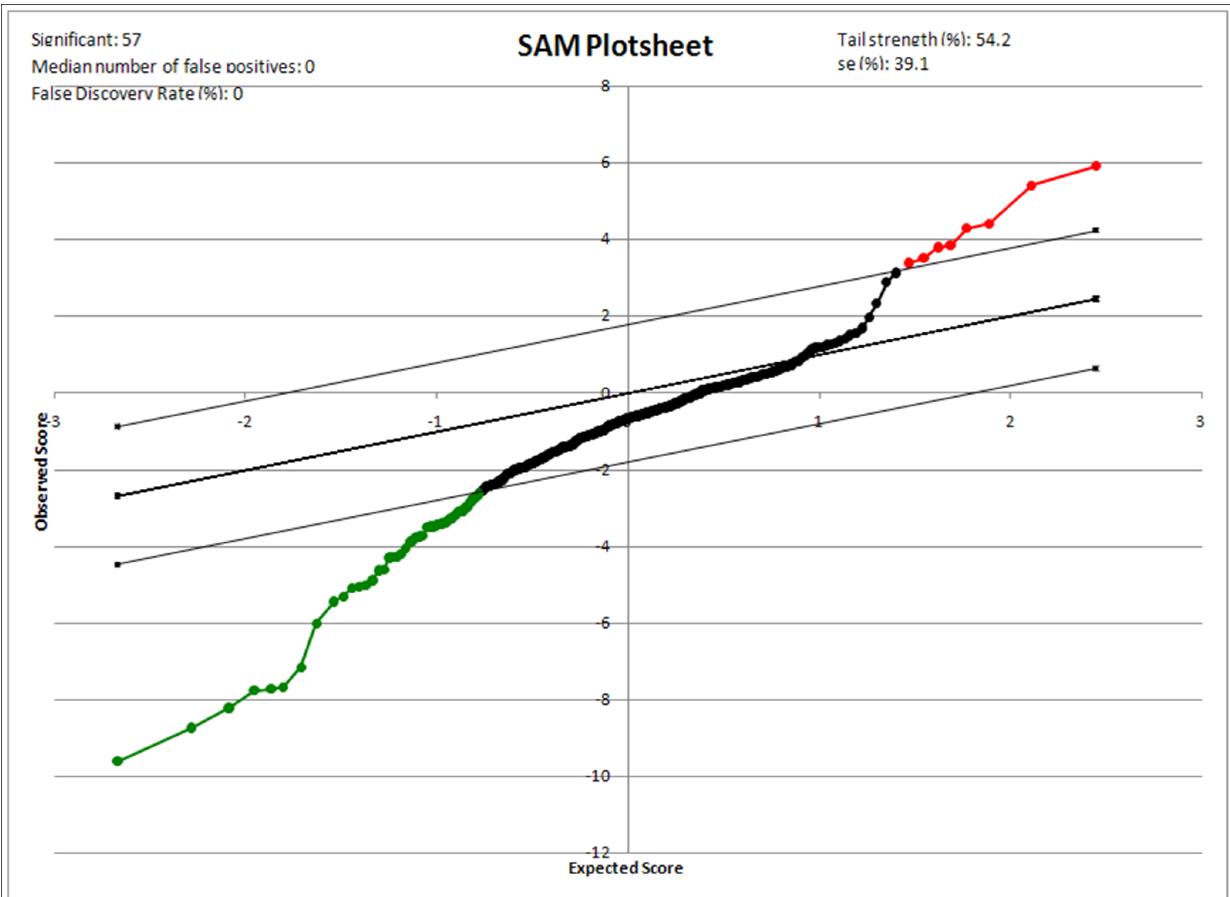
Figure 1. Significance analysis of microarrays (SAM) plotsheet showing the relative expression of miRNA genes from paired-class t- test. foot note: Red dots indicate highly expressed genes and green dots indicate lower expressed genes with 1.5-fold change.